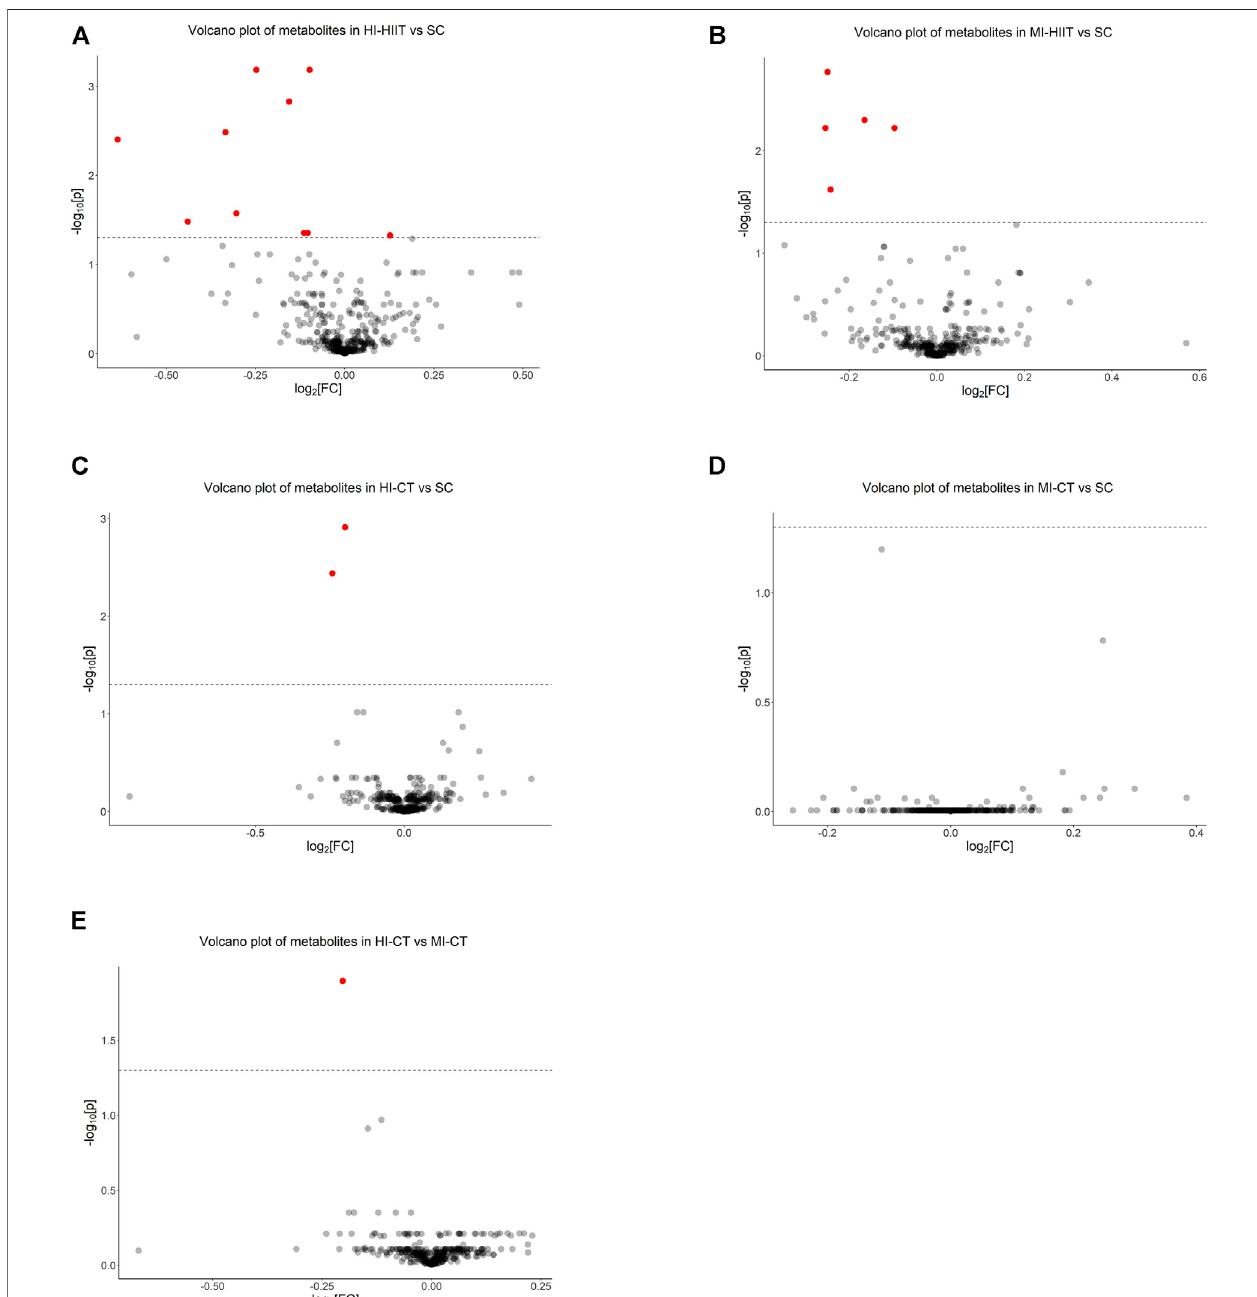
FIGURE 3 | Metabolomics analysis identi fi ed (A) 11 signi fi cant metabolites between HI-HIIT and SC, (B) fi ve signi fi cant metabolites between MI-HIIT and SC, (C) two signi fi cant metabolites between HI-CT and SC, (D) no signi fi cant metabolite between MI-CT and SC, and (E) one signi fi cant metabolite between HI-CT and MI-CT groups. The dash line represents the cutoff value at a negative log-transformed signi fi cance level of 0.05 (i.e., − log 10 [ 0 . 05 ] (cid:2) 1 . 3). HI-HIIT: high training intensity HIIT group; MI-HIIT: moderate training intensity HIIT group; HI-CT: high training intensity CT group; MI-CT: moderate training intensity CT group; SC: sedentary control